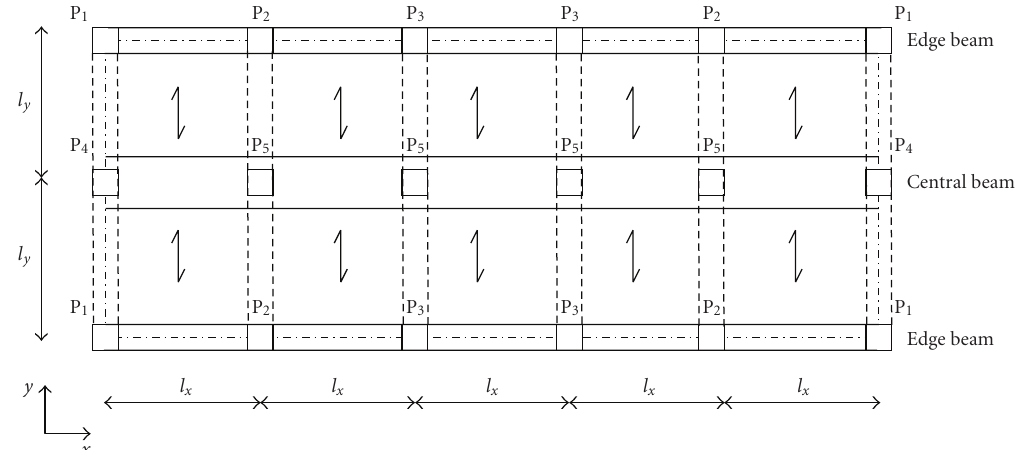
Figure 3: Plan view of the RC frame building assumed as representative of the building structural type for seismically designed buildings in Mediterranean